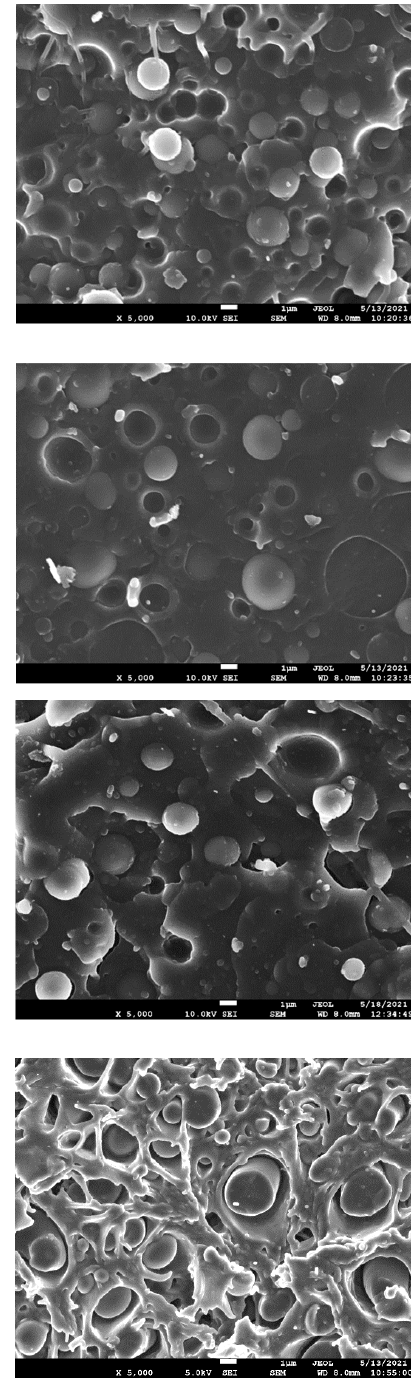
Figure 1. SEM micrographs of cryofractured cross-sections of the PLA-based blends. Left column magnification ×1000, right column magnification ×5000.